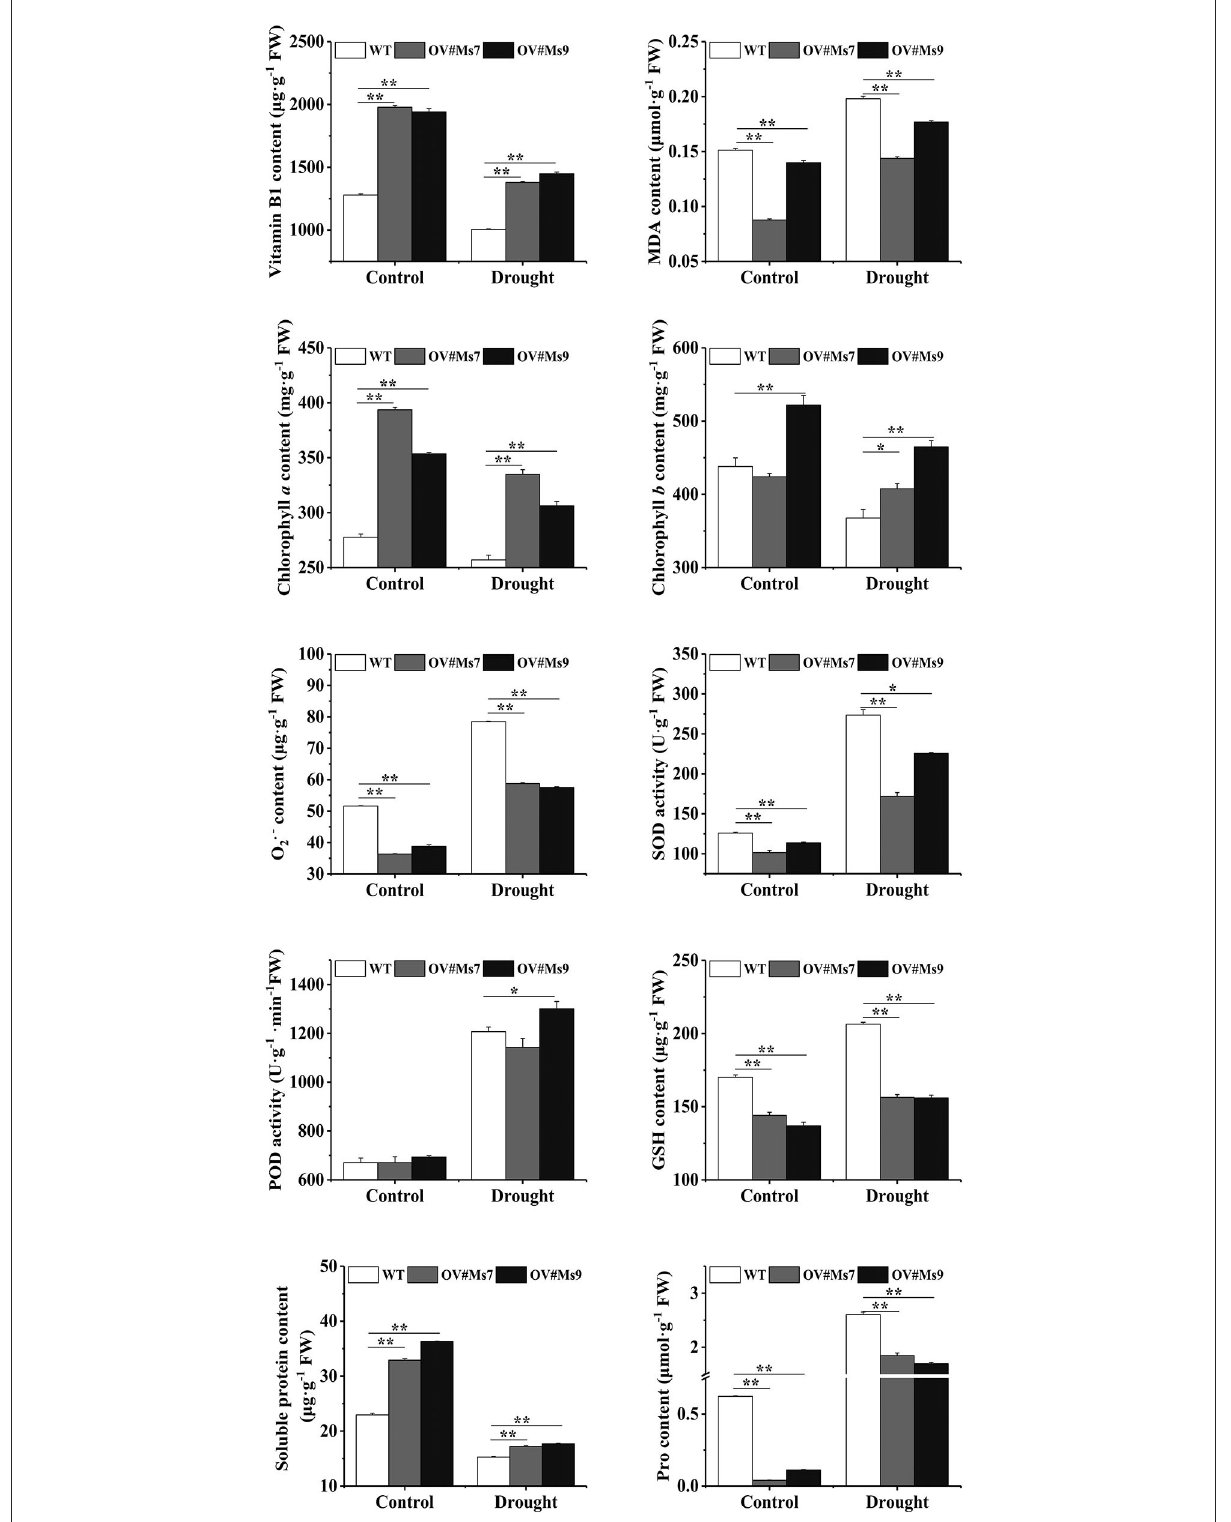
FIGURE5 Physiological changes of transgenic alfalfa plants with overexpressing MsTHI1 under control and drought stress. Mean ± standard deviations from three biological replicates are depicted with error bars. MDA, malondialdehyde. O . − 2 superoxide anion radical. SOD, superoxide